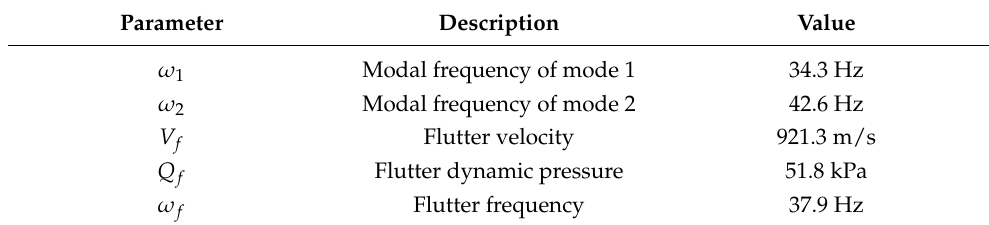
Figure 3. Mode shapes of the all-movable fin. Table 2. Linear flutter results of the all-movable